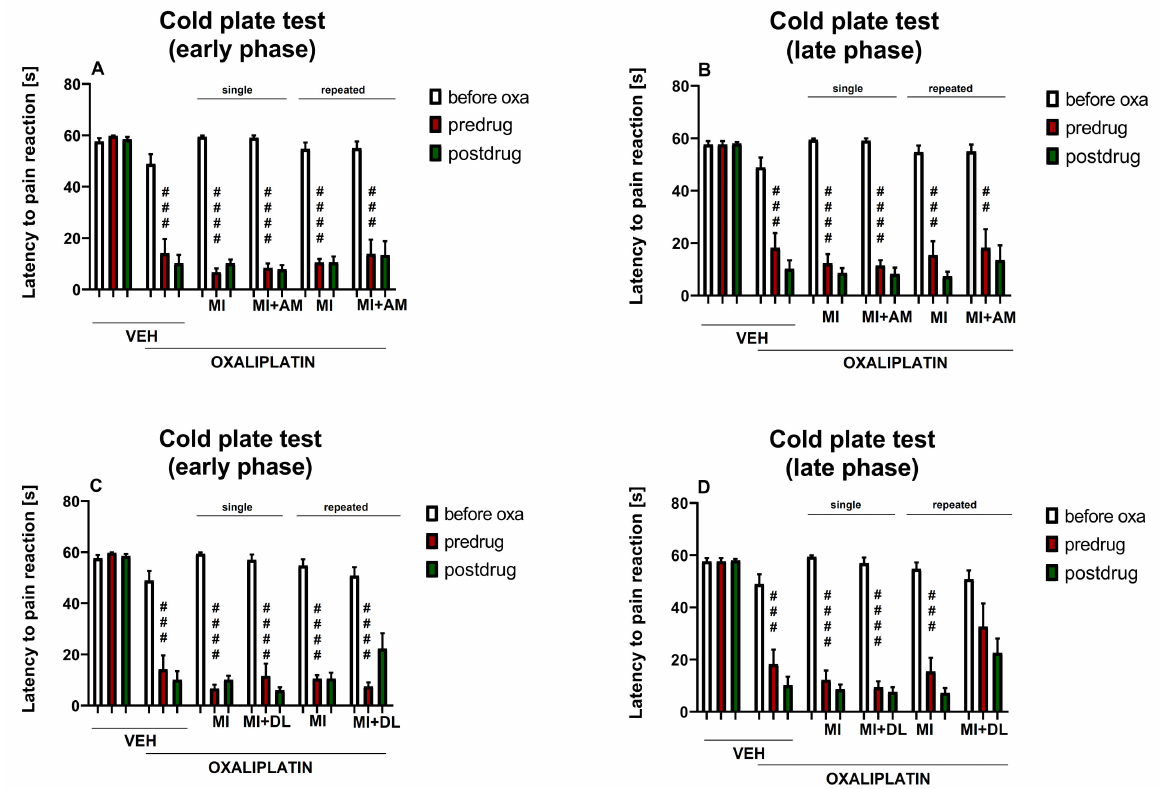
Figure 6. Effect of single-dose and repeated-dose minocycline combined with ambroxol or duloxetine on pain threshold in oxaliplatin-treated mice. Effect of minocycline (50 mg/kg, i.p.) combined with ambroxol (90 mg/kg, i.p.) on cold hyperalgesia measured in the cold plate test on the day of oxaliplatin administration ( A ) and 7 days later ( B ). Effect of minocycline (50 mg/kg, i.p.) combined with duloxetine (10 mg/kg, i.p.) on cold hyperalgesia measured in the cold plate test on the day of oxaliplatin administration ( C ) and 7 days later ( D ). The results for minocycline used in combination and minocycline used alone (50 mg/kg) are shown as the mean latency to pain reaction ± SEM for n = 9–10. Statistical analysis: repeated measures ANOVA followed by Tukey’s post-hoc comparison. Significance: ## p < 0.01, ### p <